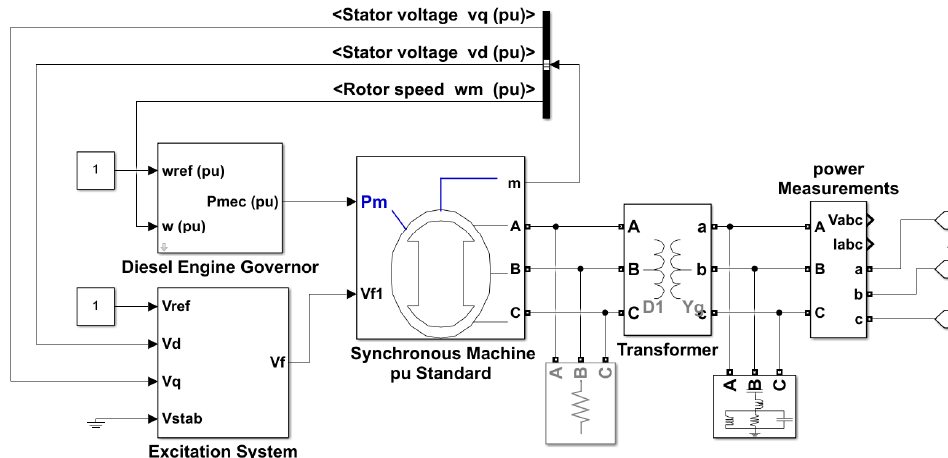
Figure 5. Model of the diesel generator.